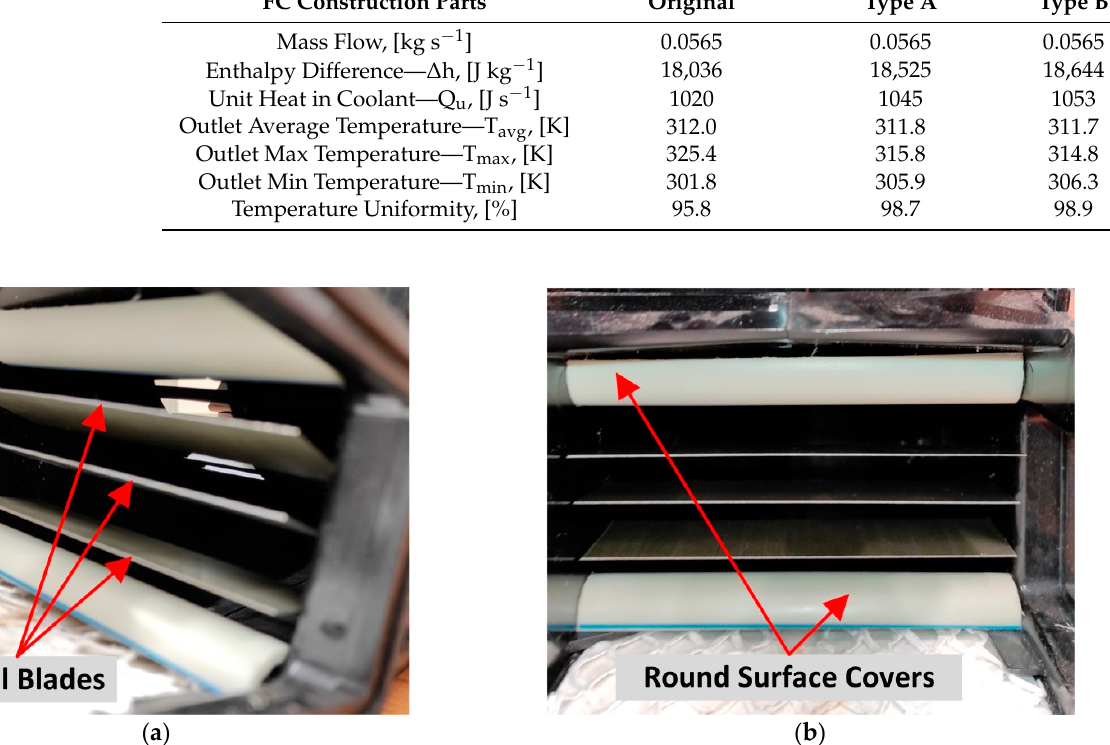
Figure 18. NEXA PEMFC stack IR-thermography at loads P = 1000 W in ( a ) original design and ( b ) modified cooling duct (Type B).